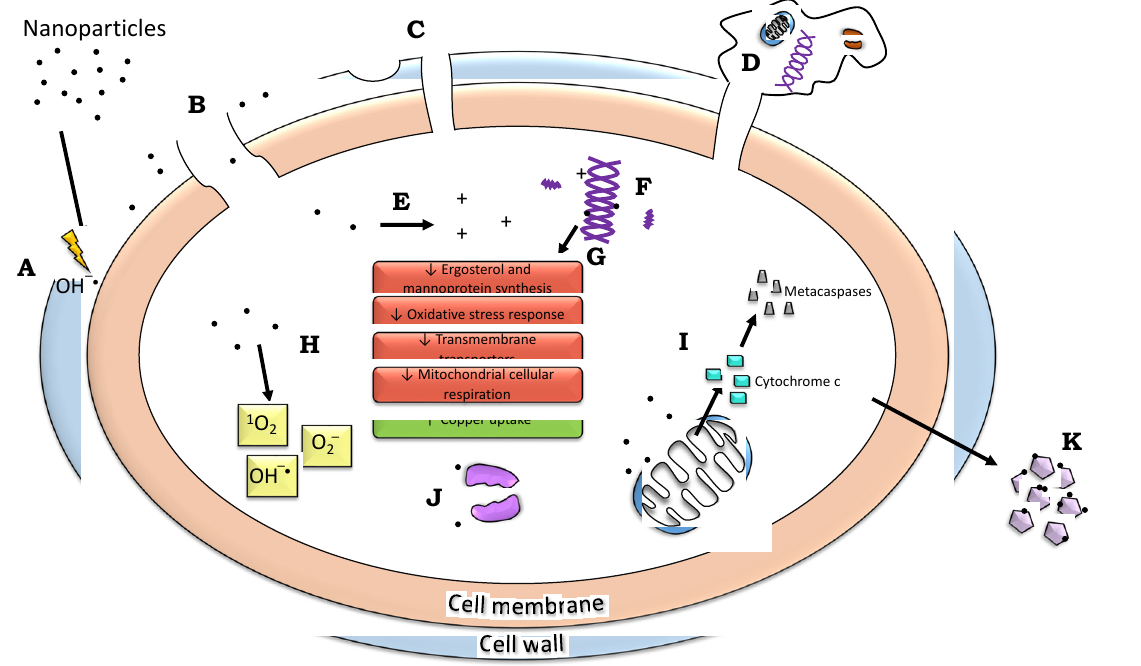
Figure 5. NPs mechanisms at the cellular level that lead to fungal cell damage include (A) ROS- inducing lipid peroxidation, (B) adsorption embedment and breakage of cell wall and membrane, (C) pit and pore formation, (D) leakage, releasing DNA and organelles from the cell, (E) ion release, (F) DNA intercalation, causing condensation and fragmentation, (G) gene expression changes, (H) ROS generation, (I) Mitochondrial release of cytochrome C into the cytosol, increasing metacaspase levels, leading to apoptosis cascade, (J) ribosome depolymerization, and (K) adsorption onto EPS, inhibiting biofilm formation.